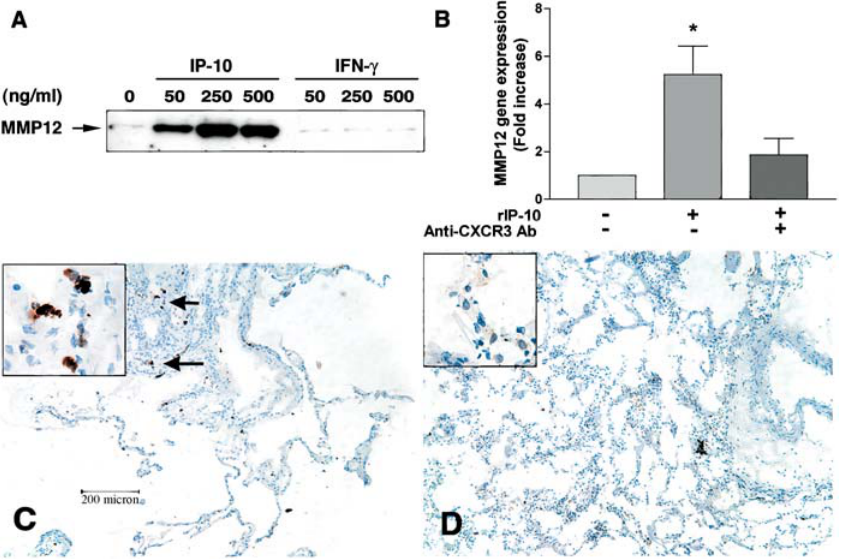
Figure 4. Regulation of MMP12 by Type 1 Cytokines (A) CD14 þ , lymphocyte-depleted lung leukocytes were cultured with and without the indicated amounts of recombinant human IP-10 and IFN- c , and supernatants were assessed for the presence of MMP12 by Western blotting. (B) Fold increase relative to unstimulated of MMP12 mRNA from lung macrophages stimulated without ( – ) and with ( þ ) 500 ng/ml of IP-10 in the presence or absence of a function-blocking antibody to CXCR3 as determined by real-time PCR. (C and D) Lung tissue from a participant with emphysema (C) shows strong immune staining for MMP12 localized to macrophages (arrows), and (D) shows lung tissue from a control participant without emphysema and with undetectable MMP12. The insets show a high-power view of lung macrophages staining positive (C) and negative (D) for MMP12 ( 3 60) *, p = 0.04. DOI: